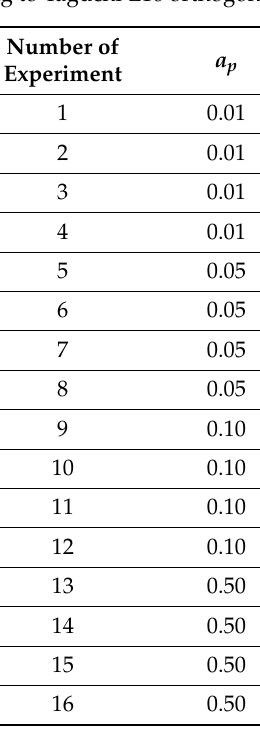
Table 4. Experimental results for parameters—flank wear ( VB B ) and diameter deviation ( ∆ d ) accord- ing to Taguchi L16 orthogonal